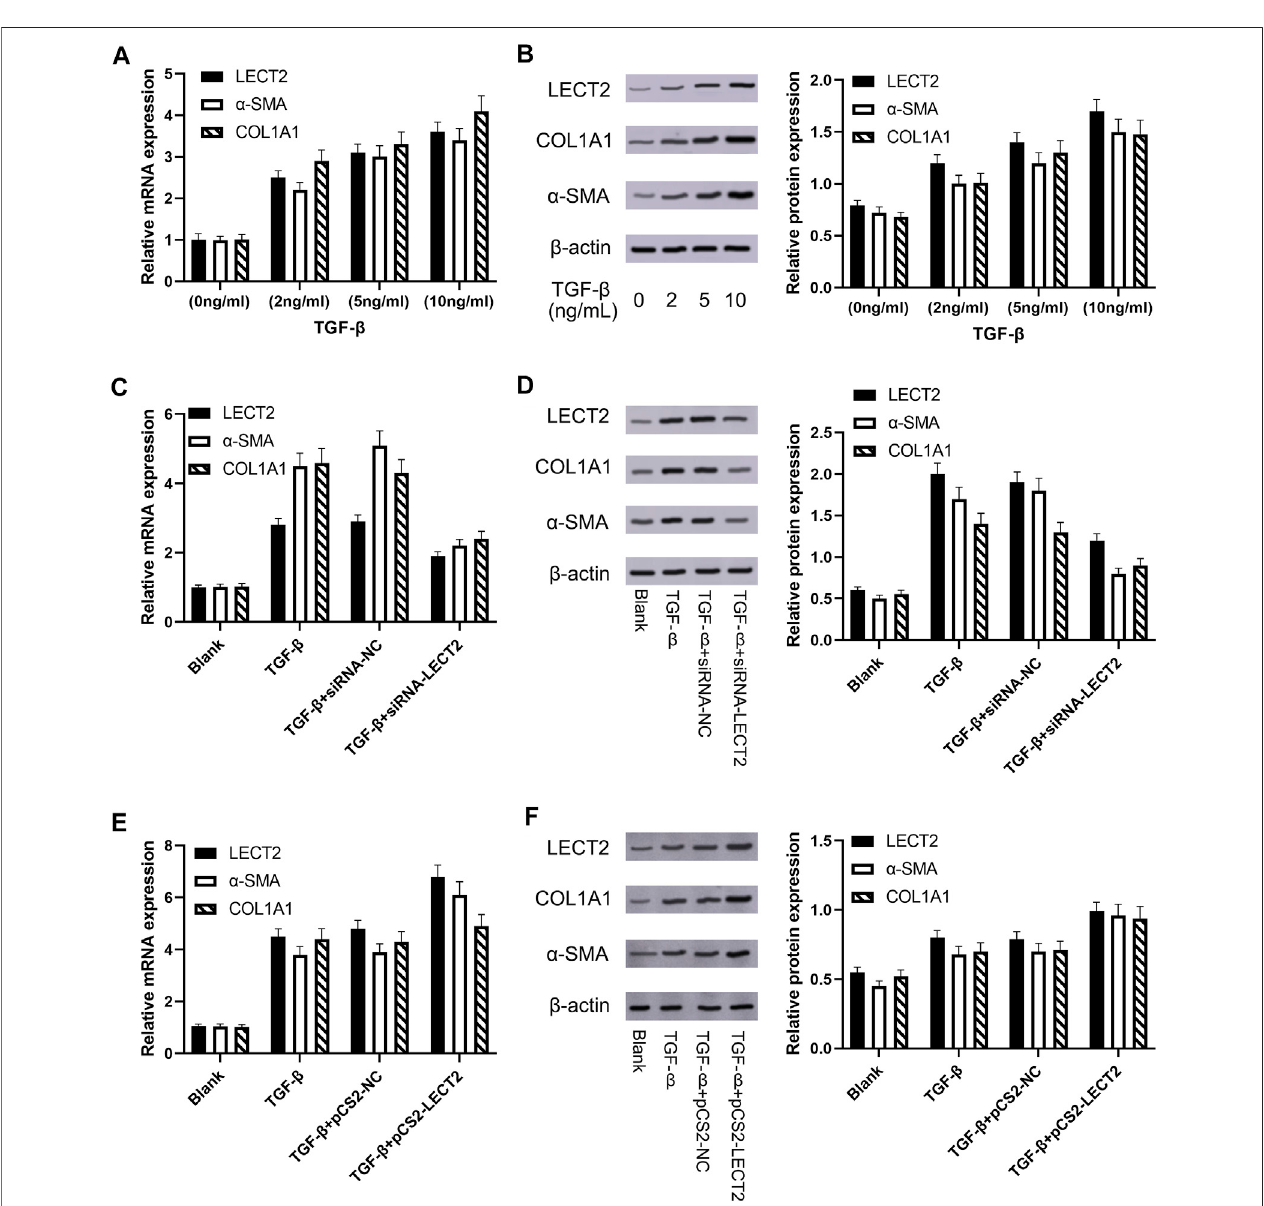
FIGURE5| Theexpression ofLECT2, a -SMAand COL1A1inLX-2cells (A) Theeffect ofTGF- β on LECT2, a -SMAand COL1A1mRNA (B) Theeffect ofTGF- β on LECT2, a -SMA and COL1A1 protein (C) siRNA-LECT2 inhibits the mRNA expression of a -SMA and COL1A1 in LX-2 cells (D) siRNA-LECT2 inhibits the protein expression of a -SMA and COL1A1 in LX-2 cells (E) Overexpression of LECT2 resulted in an increase in a -SMA and COL1A1 mRNA levels (F) Overexpression of LECT2 resulted in an increase in a -SMA and COL1A1 protein levels.